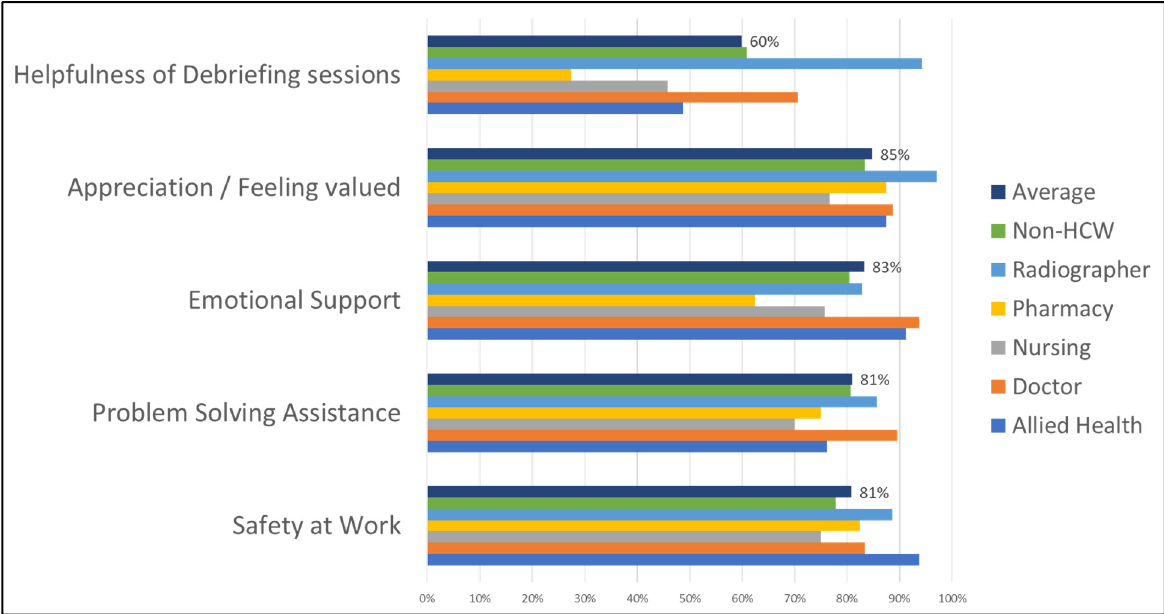
Figure 2. Level of support score per sta ff category.